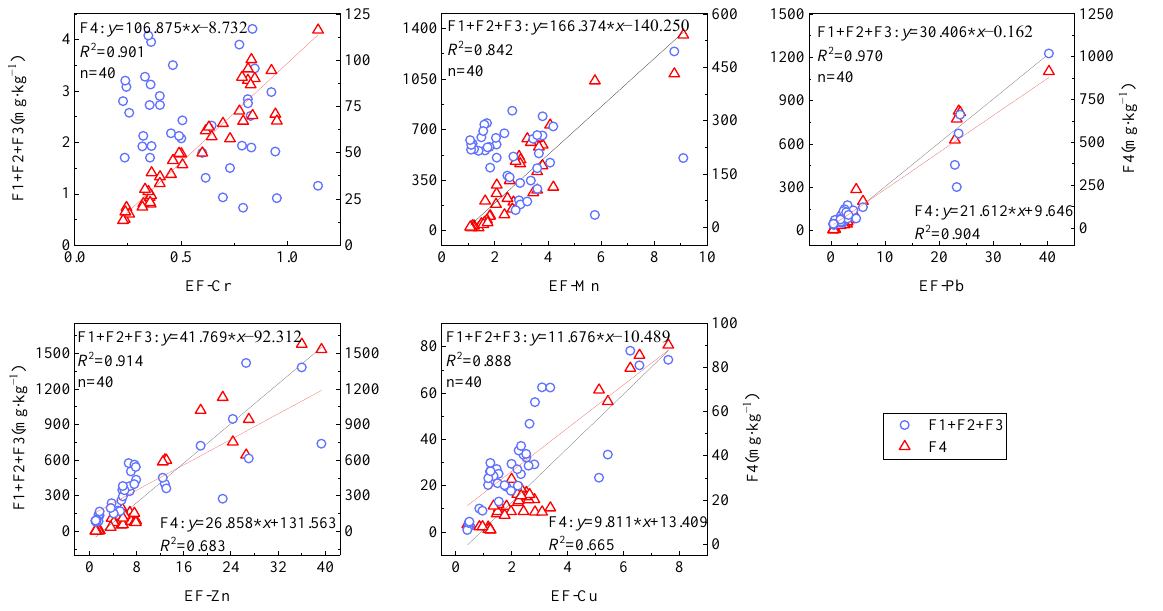
Figure 9. The EF and correlation of HMs in soil sediments in the study area. (Note: F1+F2+F3: light blue circle represents the sum of F1, F2, and F3 heavy metals; F4: the red triangle represents the content of F4 heavy metals).